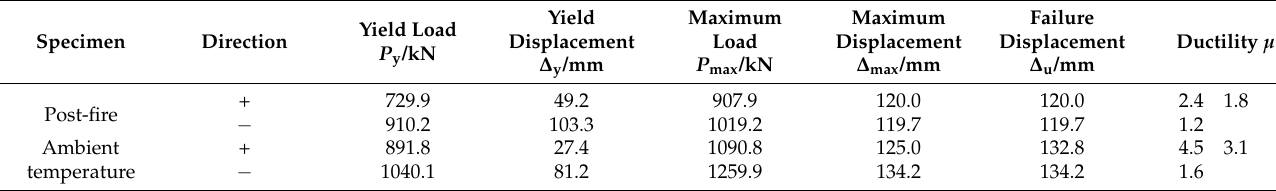
Table 3. The results of ductility.